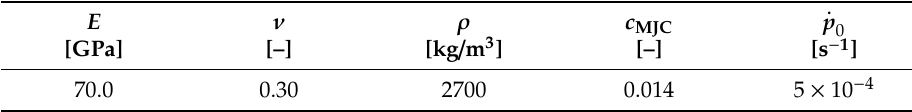
Table 5. Material constants for aluminium alloy AA1050-H14 (from